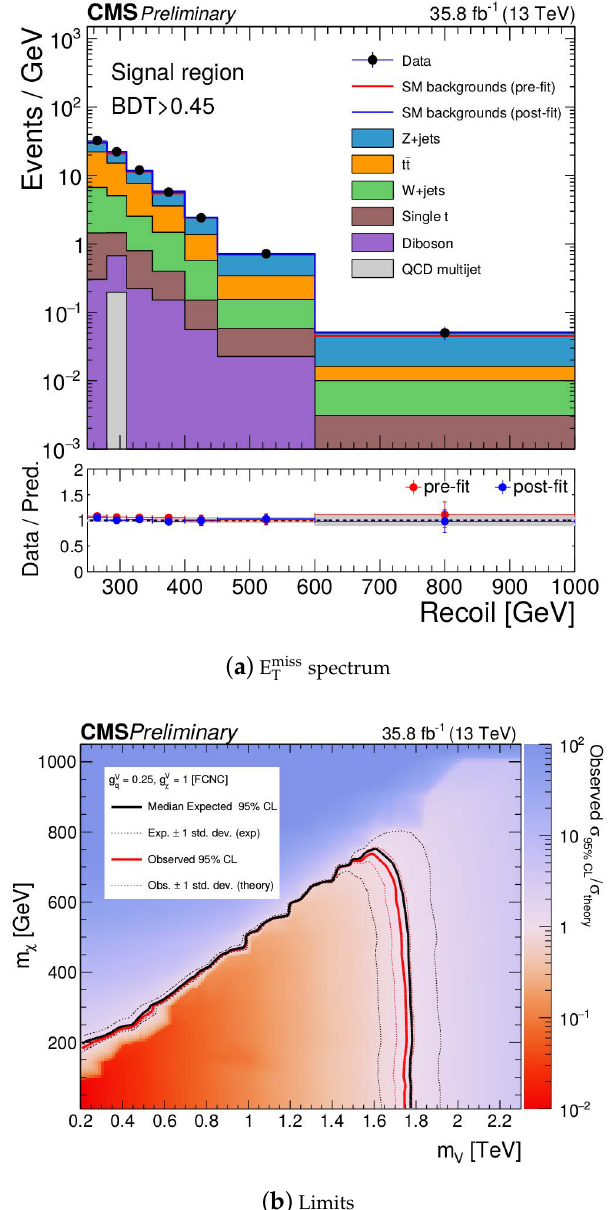
Figure 6. E miss distribution in the mono-top [13] signal region ( a ), and limits on the mass of the vector T boson (flavor-changing neutral current (FCNC)) versus the mass of the DM particle ( b ). The coupling of the vector boson to quarks (g V q ) is set to 0.25 and the coupling to DM (g V χ ) to